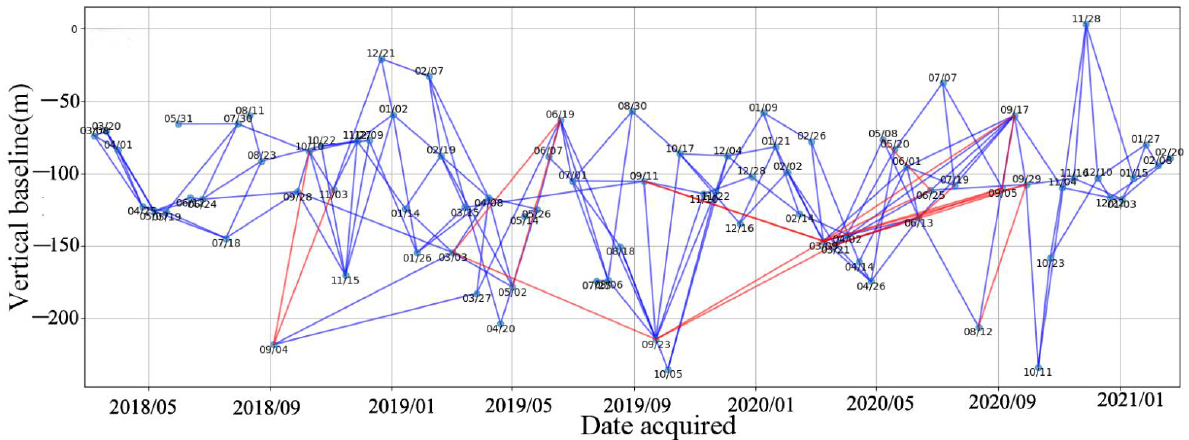
Figure 18. Interference-pair space-time baseline distribution map.